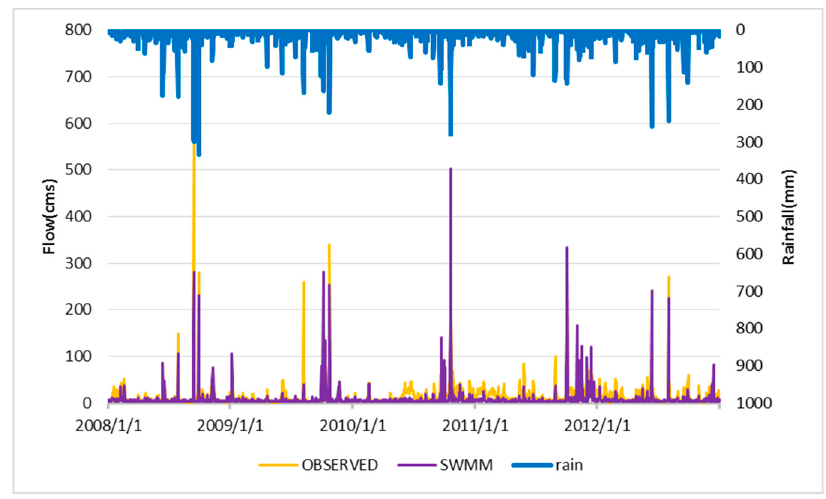
Figure 5. Flow simulation results for the SWMM model.